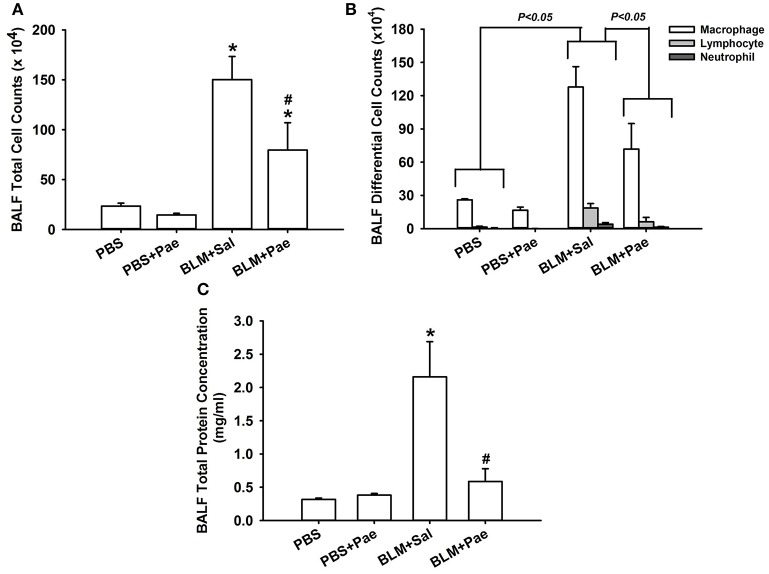
Treatment with paeonol (Pae) alleviates bleomycin (BLM)-induced increase in indices of pulmonary inflammation in mice. The indices measured were total cell count (A), differential cell count (B), and total protein concentration (C) in bronchoalveolar lavage fluid (BALF) sampled from mice of 4 study groups. Data in each group are mean ± SEM from 6 mice. *p < 0.05 vs. the PBS group; #p < 0.05 vs. the BLM group. See legend of Figure 1 for treatments of 4 study groups. See the legend of Figure 1 for detailed information on each study group.